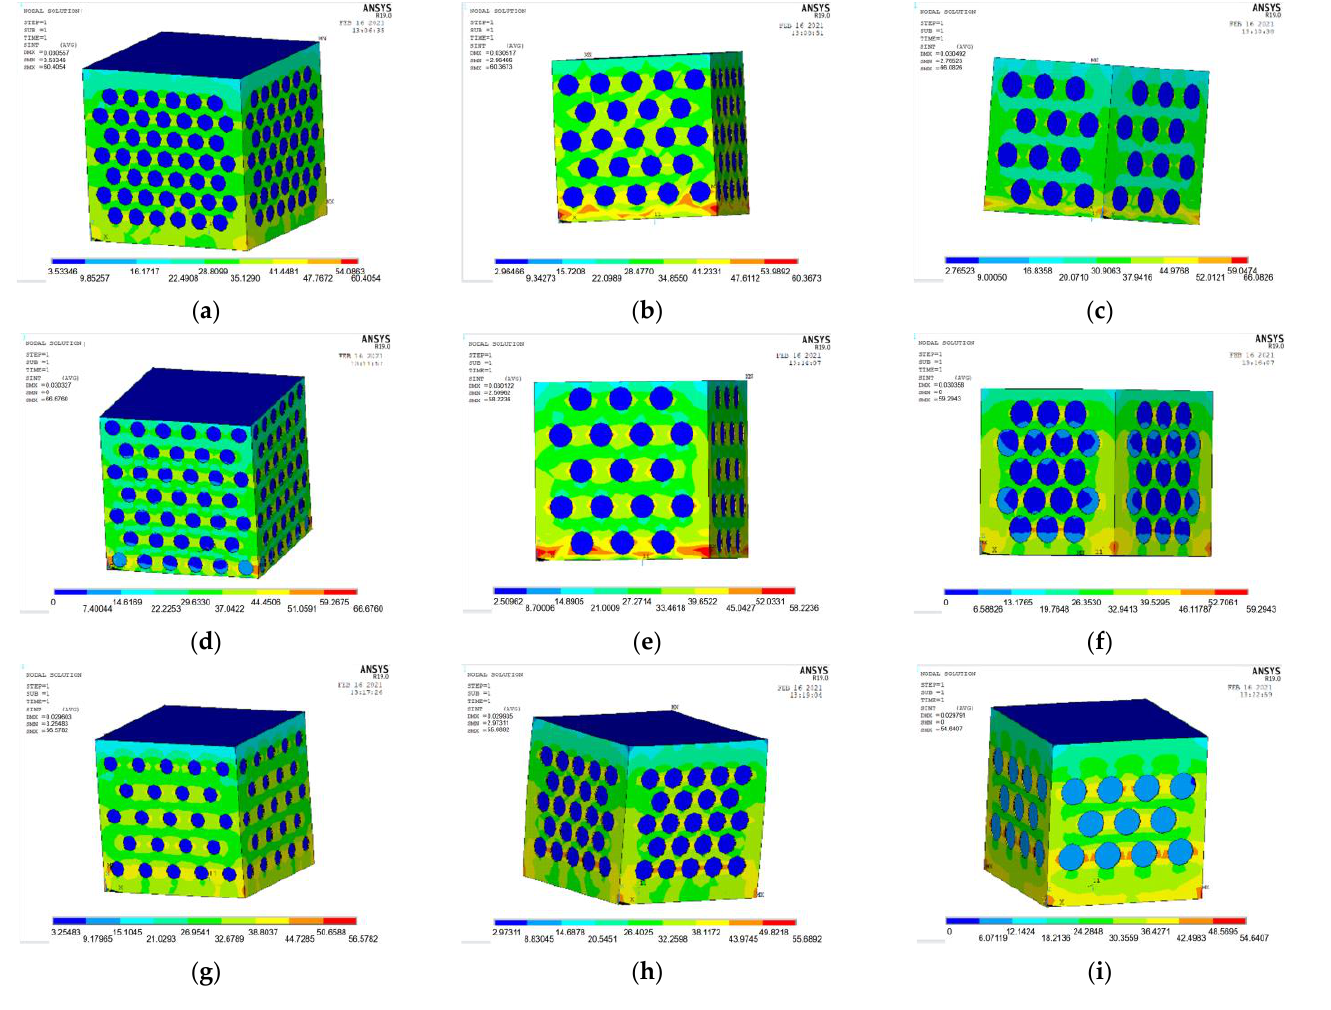
Figure 15. Stress cloud images of nine groups of compression perforated steel plate reinforced concrete sam-ples: ( a ) test number 1; ( b ) test number 4; ( c ) test number 7; ( d ) test number 2; ( e ) test number 5; ( f ) test number 8; ( g ) test number 3; ( h ) test number 6; ( i ) test number 9.